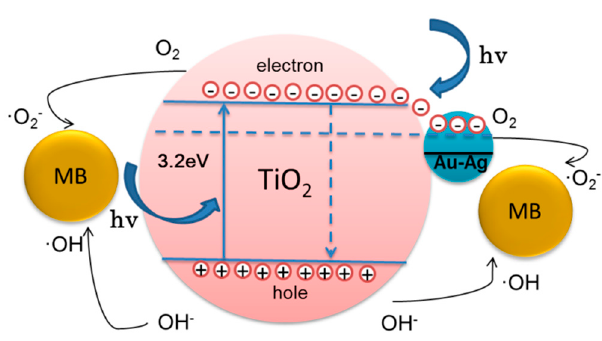
Figure 8. Mechanism of MB photodegradation by Au-Ag decorated TiO 2 composites.